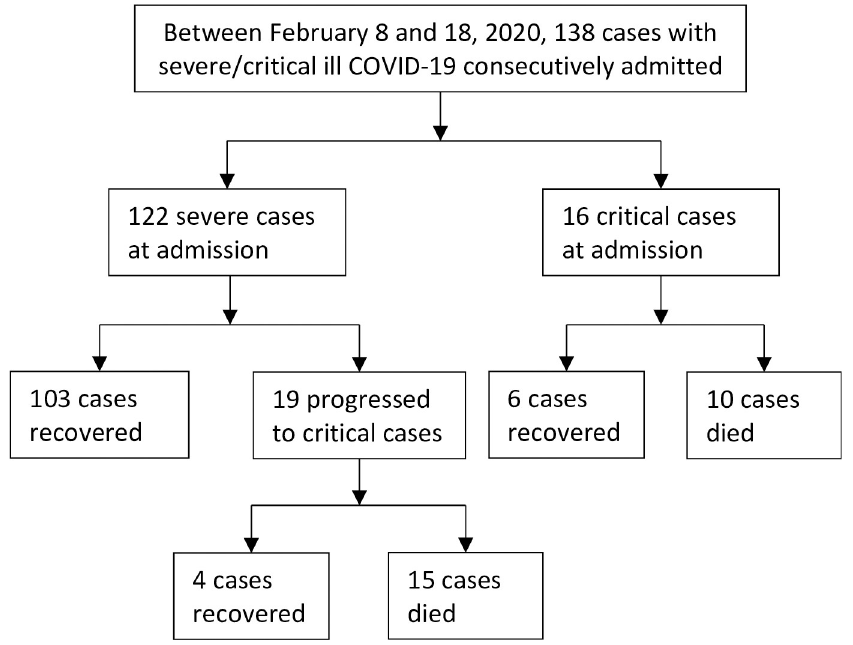
Fig 1. Study flowchart. COVID-19, Coronavirus Disease